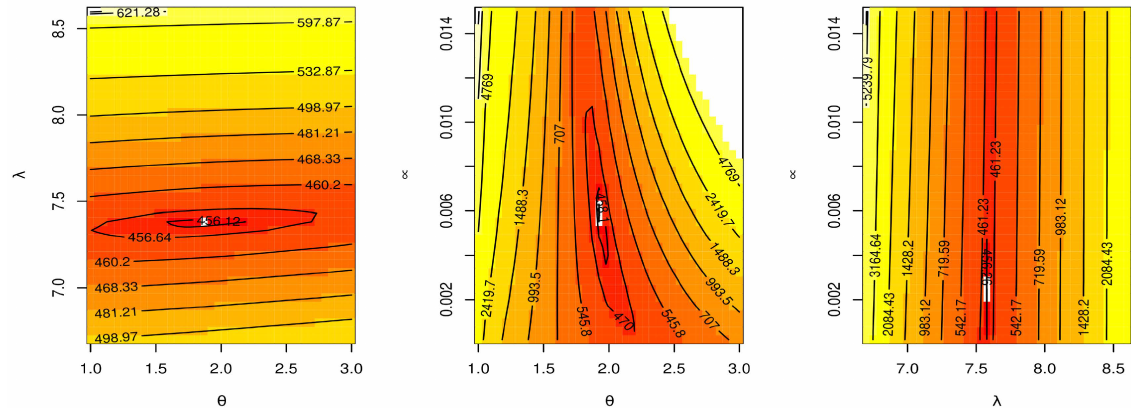
Figure 15. Contour plot for log-likelihood of the TCPWE distribution for strength data.